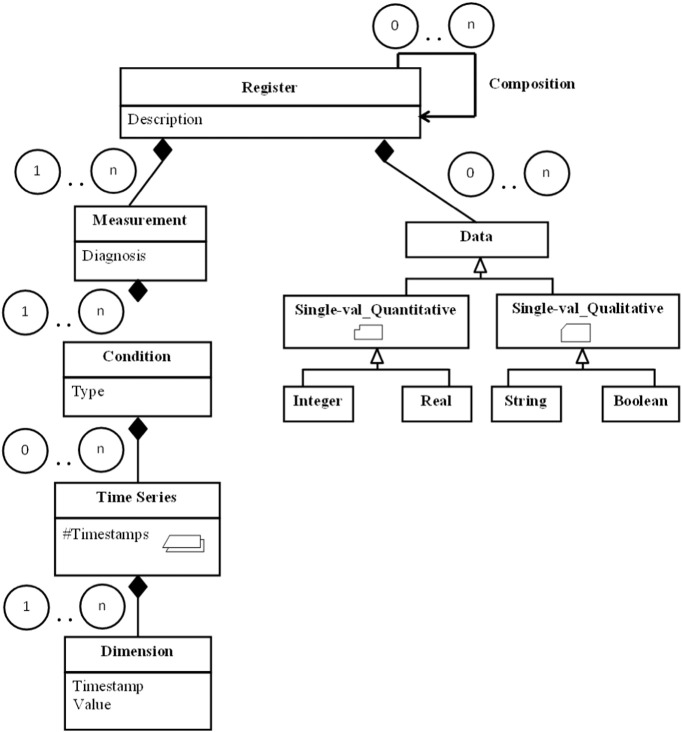
Generic UML model.